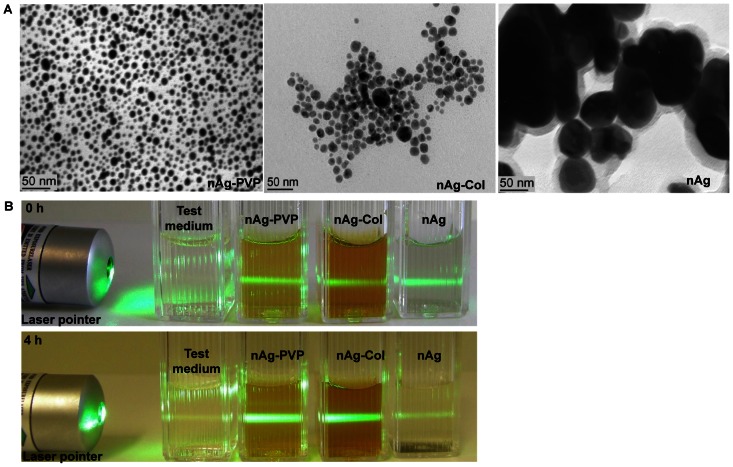
Characterization of silver nanoparticles.A: Transmission electron microscopy images of AgNPs. TEM image of collargol is reprinted from [21] with the permission of Springer. B: Stability of 10 mg/l nanoparticles suspensions in test medium (half-strength NaCl-free LB medium). After 0-h incubation (upper panel), all AgNPs suspensions scattered light upon the illumination by the laser pointer, indicating the presence of particles. After 4-h incubation (lower panel), the light scattering from uncoated nAg was negligible (comparable to that of the test medium with no AgNPs added) and settling of the particles was observed.